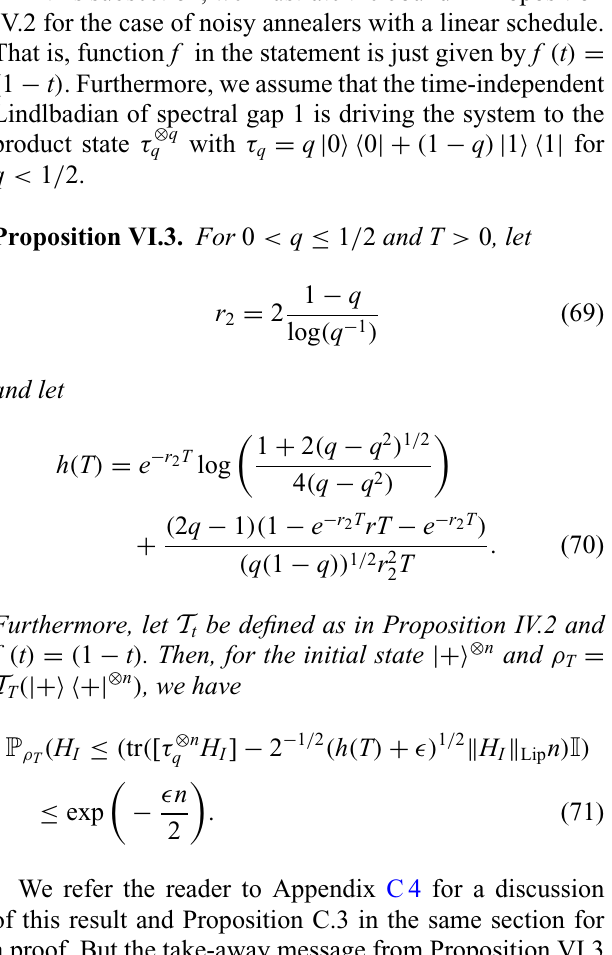
as a function q